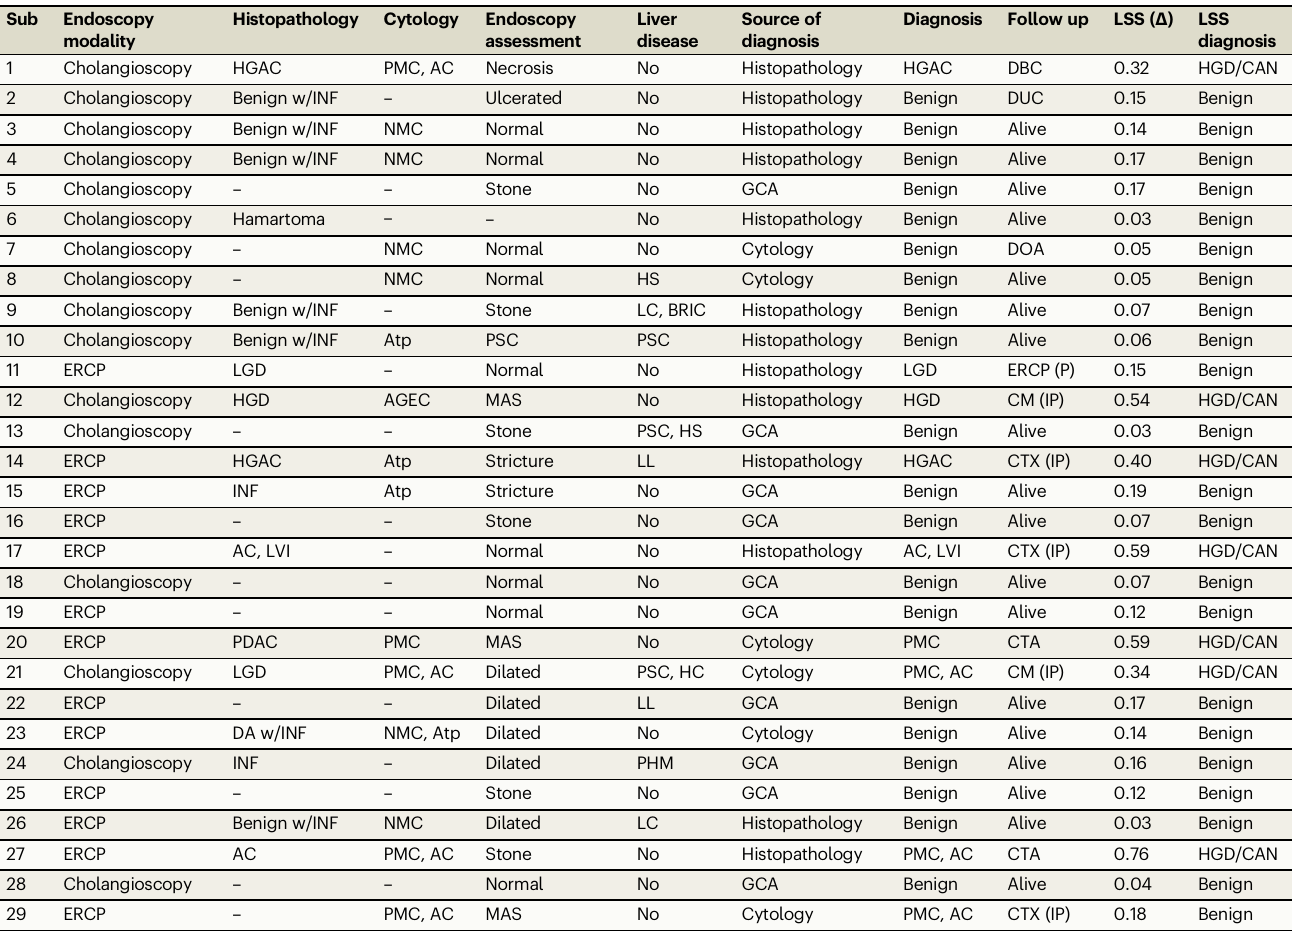
Table 1 | In vivo differentiation of bile duct neoplasms in 29 subjects Sub Endoscopy